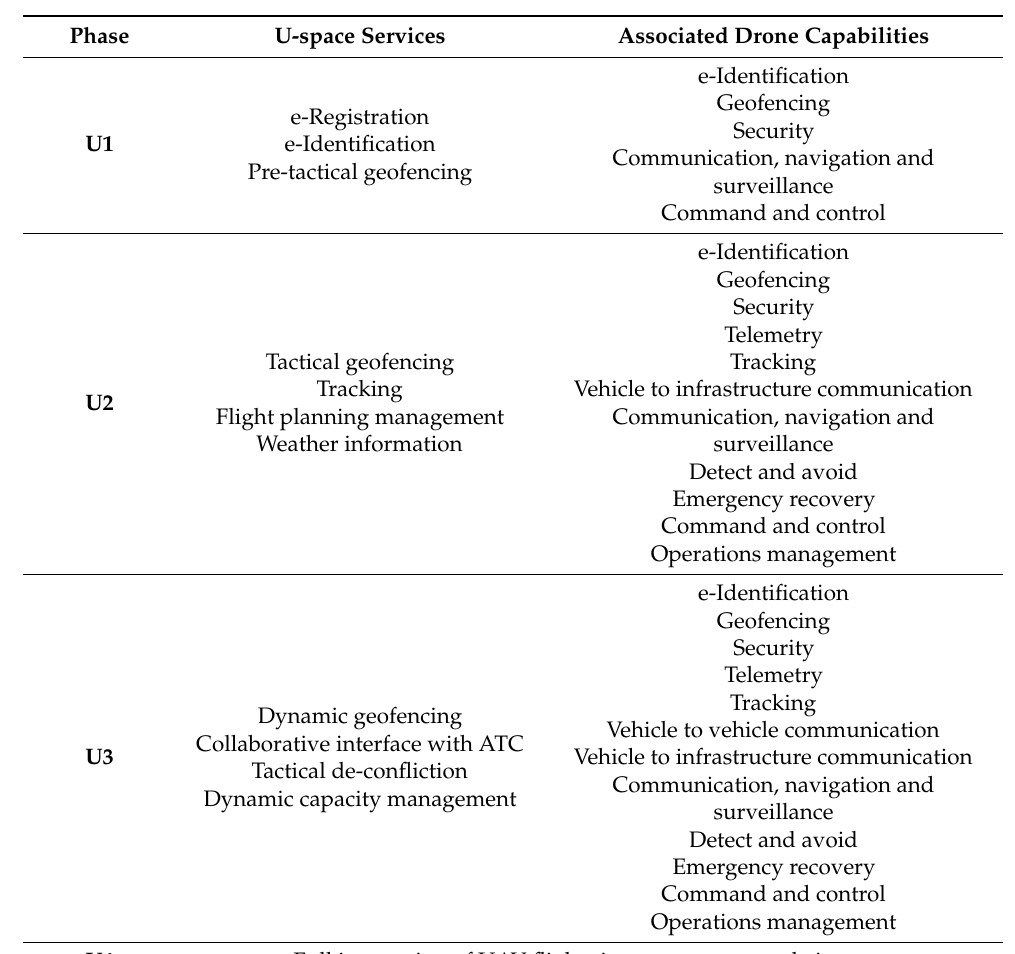
Table 1. UAS services capabilities required for U-space